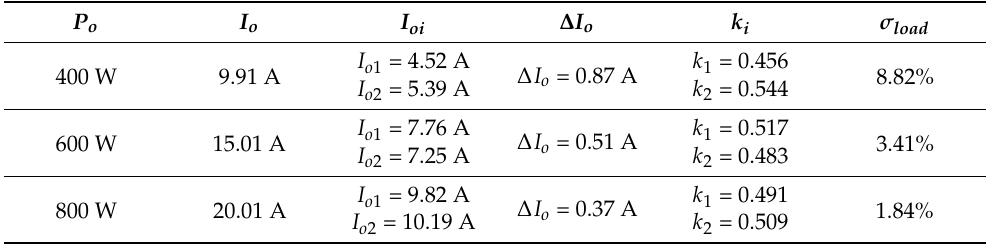
Table 7. Data comparison of different output power without current sharing control when c = 1.2. Table 8. Data comparison of different output power after only using calculation result when c =